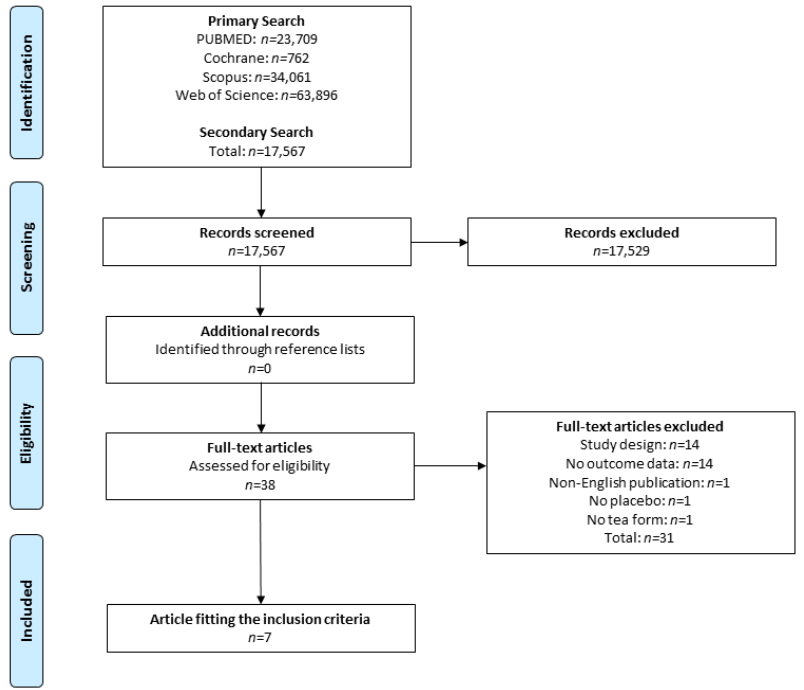
Figure 2. Schematic representation of the flow of information during the different phases of the systematic review.